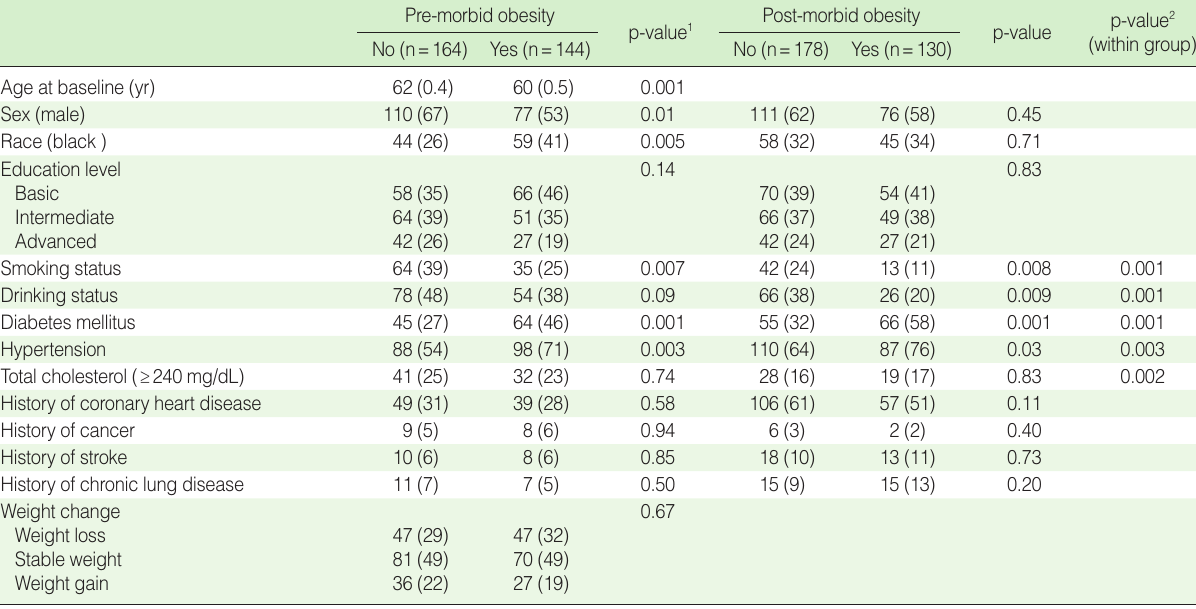
Table 1. Pre-morbid and post-morbid characteristics of 308 patients with available data before and after incident heart